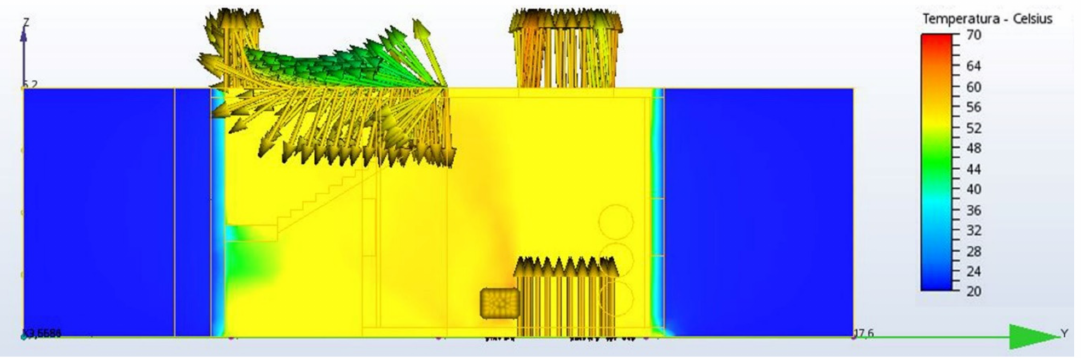
Figure 8. Model section at the cavities, with representation of the velocity